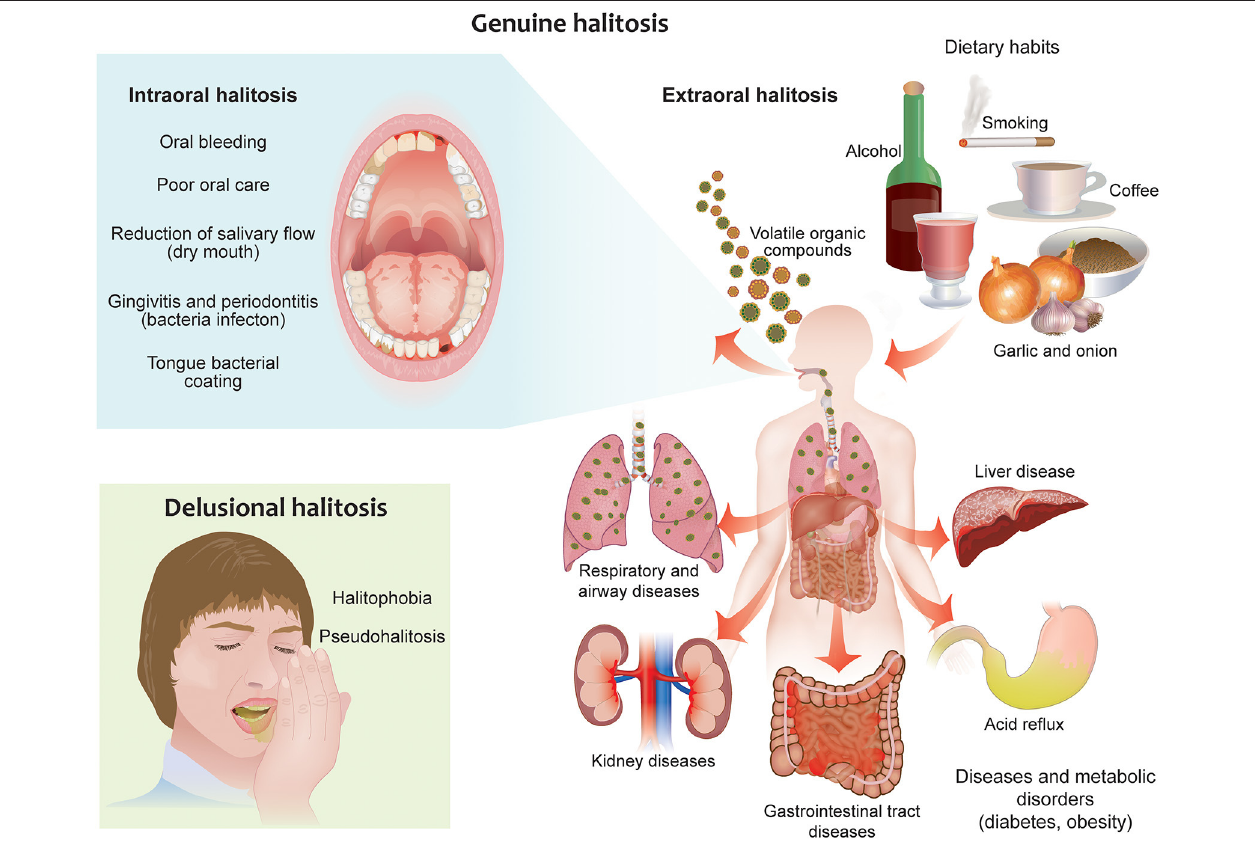
FIGURE 1 | Different forms of halitosis and their causes. Genuine halitosis can be classified as intraoral or extraoral halitosis. Intraoral halitosis originates from volatile organic compounds produced by oral bacteria resulting from poor oral hygiene, dental plaque, dental caries, oral diseases, tongue coating, and dry mouth. In extraoral halitosis, the malodor is emitted from the nasal, paranasal, laryngeal, or pulmonary regions and can be caused by serious diseases like diabetes, metabolic disorders, and kidney and liver diseases. Certain foods, beverages, and lifestyle habits, like cigarette smoking and alcohol consumption, can also contribute to halitosis. Delusional halitosis occurs when no physical or social evidence exists for the presence of halitosis (pseudohalitosis); delusional halitosis may also be related to a psychogenic or psychosomatic disorder